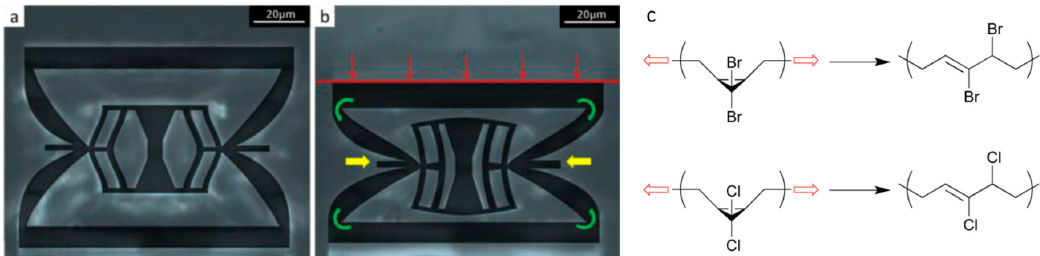
Figure 6. ( a ) Basic polymeric building block of a programmable metamaterial obtained by 3D printing in its initial state. ( b ) The intricate structure of this building block implies that under uniaxially loading (red arrows) above a specific threshold the bistable element in the center of the building block changes to a different configuration by snapping through. This structural change is accompanied by a change of the mechanical properties (from [70] with permission). ( c ) Two examples of molecules including mechanophores. Both belong to the class of gem-dihalocyclopropanes (top: gem-dibromocyclopropane, bottom: gem-dichlorocyclopropane). When applying a force as indicated by the red arrows, both molecules undergo a disrotatory ring opening reaction resulting also in a change of their mechanical properties. Using single molecule force spectroscopy experiments, the necessary force to trigger the ring opening reaction were determined to be 1210 pN and 1330 pN, respectively (from [71] licensed under CC BY 3.0). In contrast to the control functions described for processes in bone, both the mechanical metamaterial and the polymer including a mechanophore are characterized by a control function with an abrupt change in the mechanical properties at the setpoint of the mechanical stimulus.